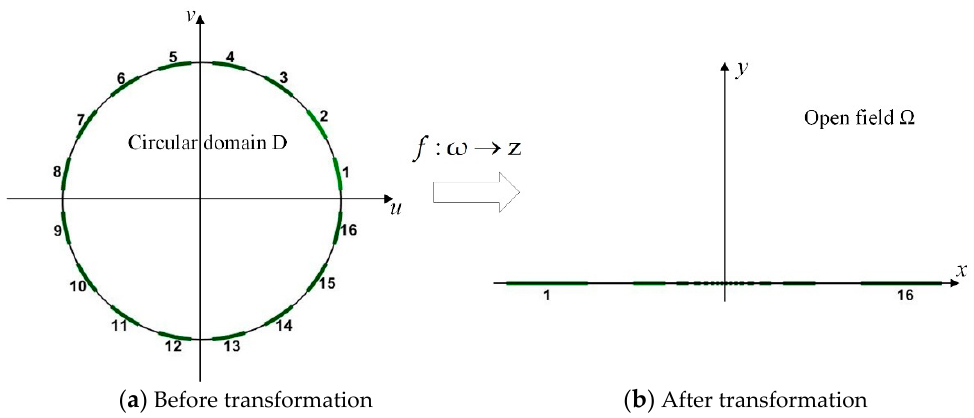
Figure 3. Conformal transformation from unit circular domain to upper half plane.